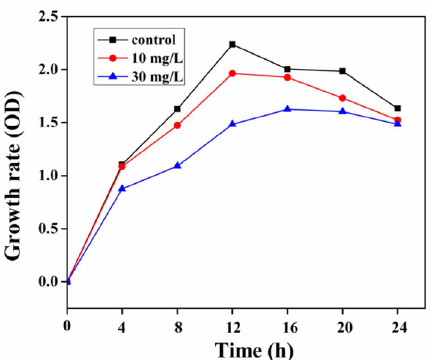
Fig. 2. Influence of Cr (VI) on bacterial growth